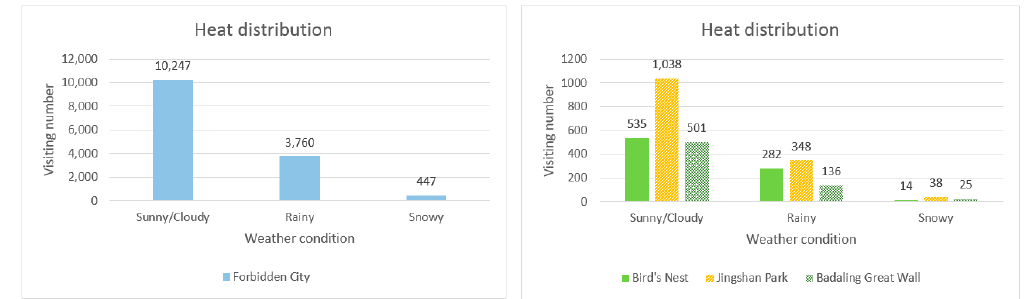
Figure 19. Heat distribution map divided by weather conditions.